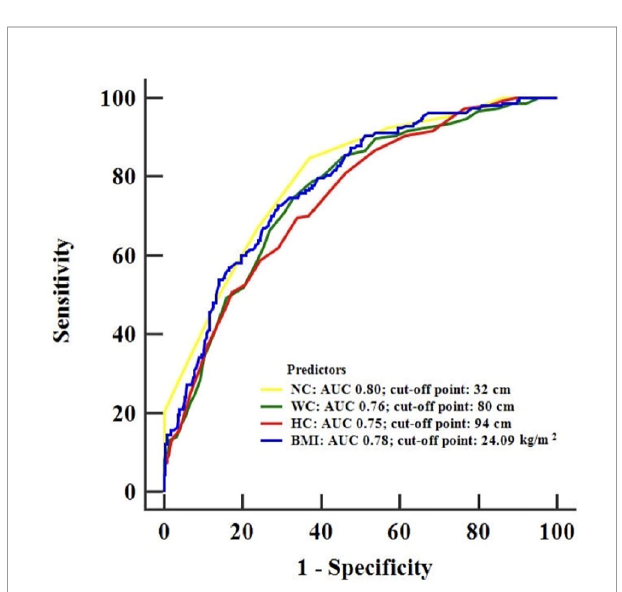
FIGURE 2 | Receiver operating characteristic curves for the detection of hyperuricemia using NC, BMI, WC and HC. NC, neck circumference; BMI, body mass index; WC, waist circumference; HC, hip